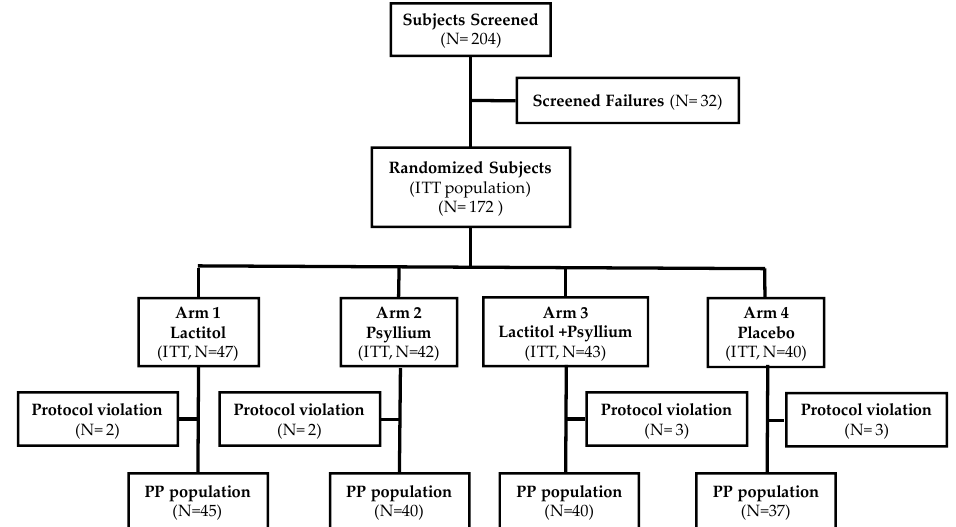
Figure 2. Disposition of volunteers. After the 2-week run-in period, 84% of volunteers were randomized into 4 treatment arms. Most randomized volunteers (94%) completed the trial. Withdrawals were evenly distributed among treatment groups. ITT—intention-to-treat; PP— per protocol.